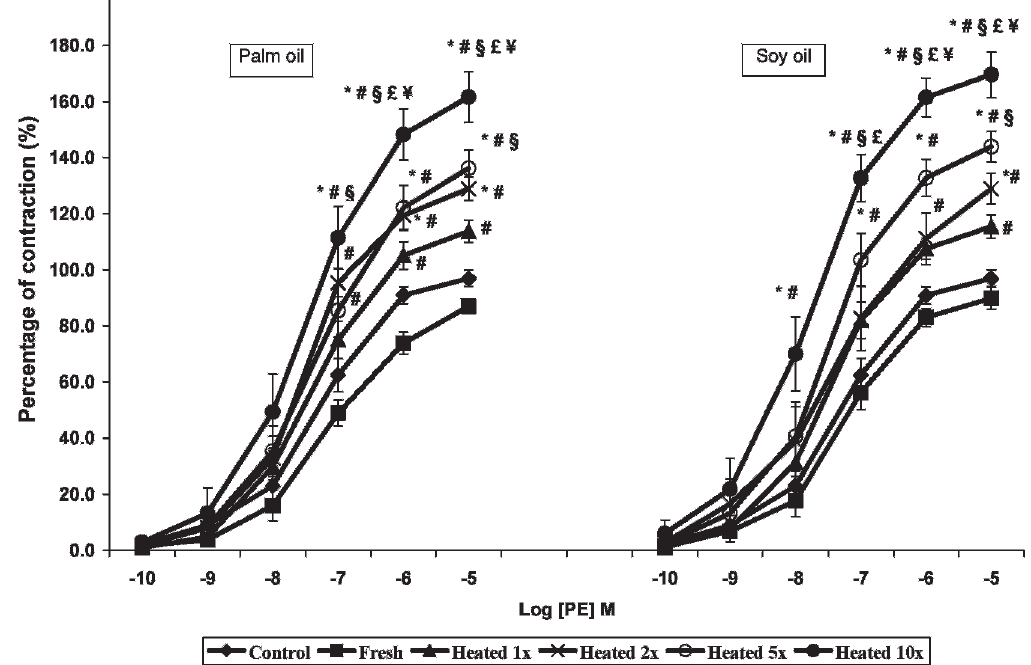
Figure 5 - Contractile response induced byphenylephrine(PE) in aortic rings isolatedfrom rats that were fedfor24 weeks with a basaldiet (control), fresh palm or soy oil, or palm or soy oil that washeated once (1x), twice (2x), five times (5x), or ten times (10x). The results are the means ¡ SEM (n=10) . Significant difference ( p , 0.05) versus the * control, # fresh oil group, 1 1x heated-oil group, £ 2x heated-oil group, or ¥ 5x heated-oil group. Dose response curves are plotted as percentage of maximum contraction obtained with high K